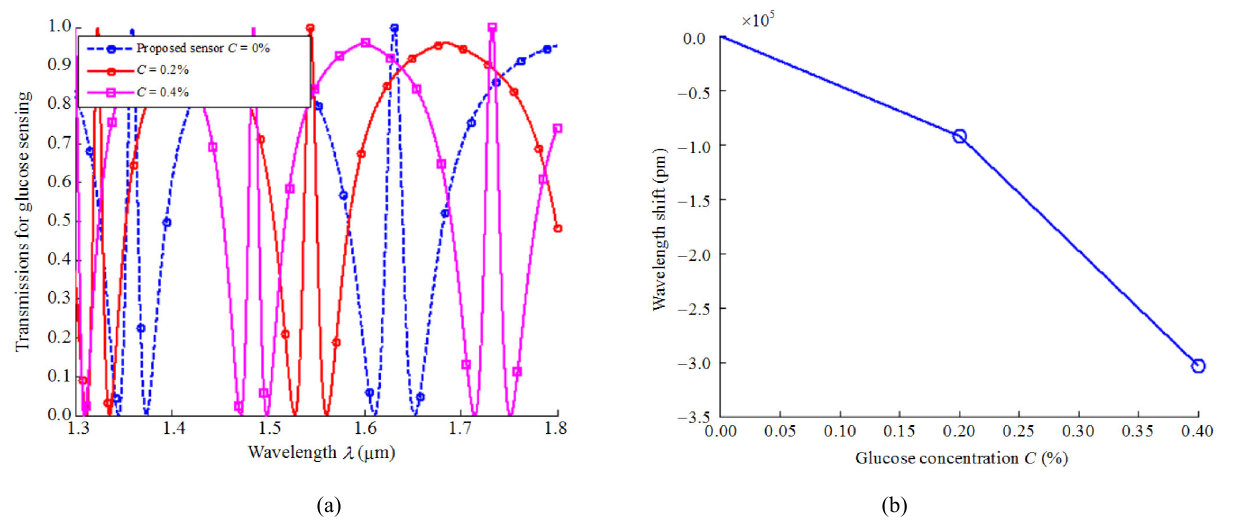
Fig. 6 Characteristics of the glucose sensor: (a) transmissions at the output port 1 for glucose sensing and (b) resonance wavelength shift at different glucose